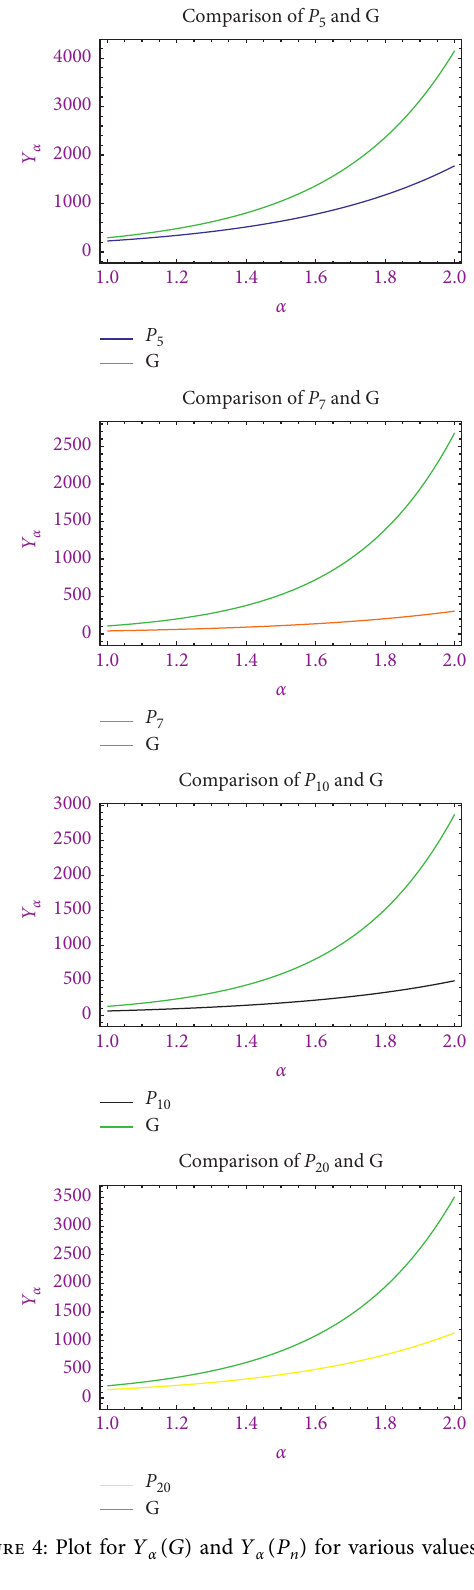
Comparison of P